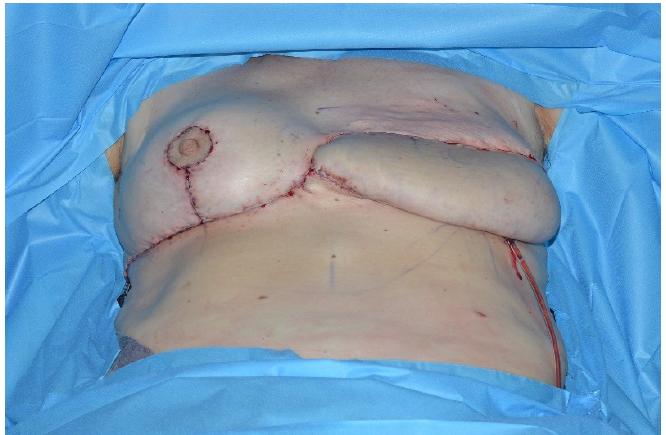
Figure 6. Immediate postoperative result.